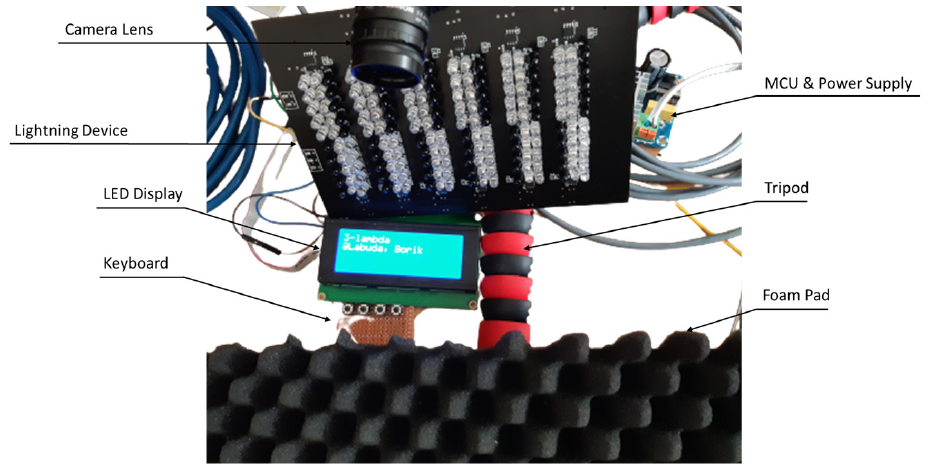
Figure 11. Measuring system configuration.